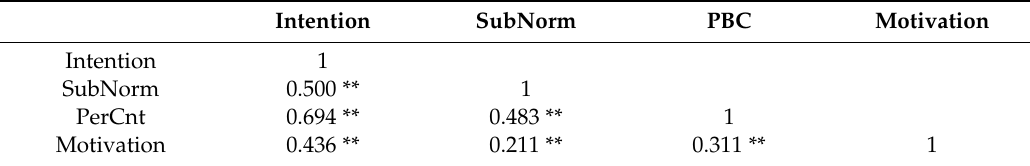
Table 2. Correlations.